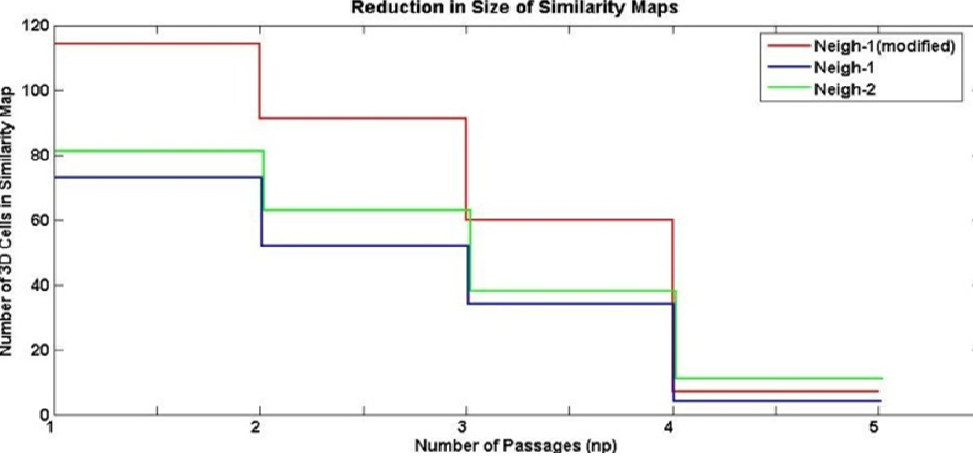
Figure 7. The progressive reduction of the size of similarity map, S